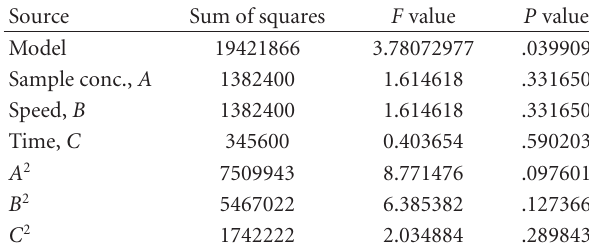
Table 6: Analysis of variance (ANOVA) for 3 ∗∗ (3-1) Fractional Factorial